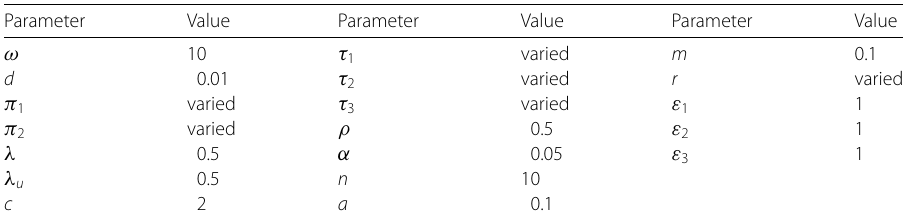
Table 1 The data of model (2)